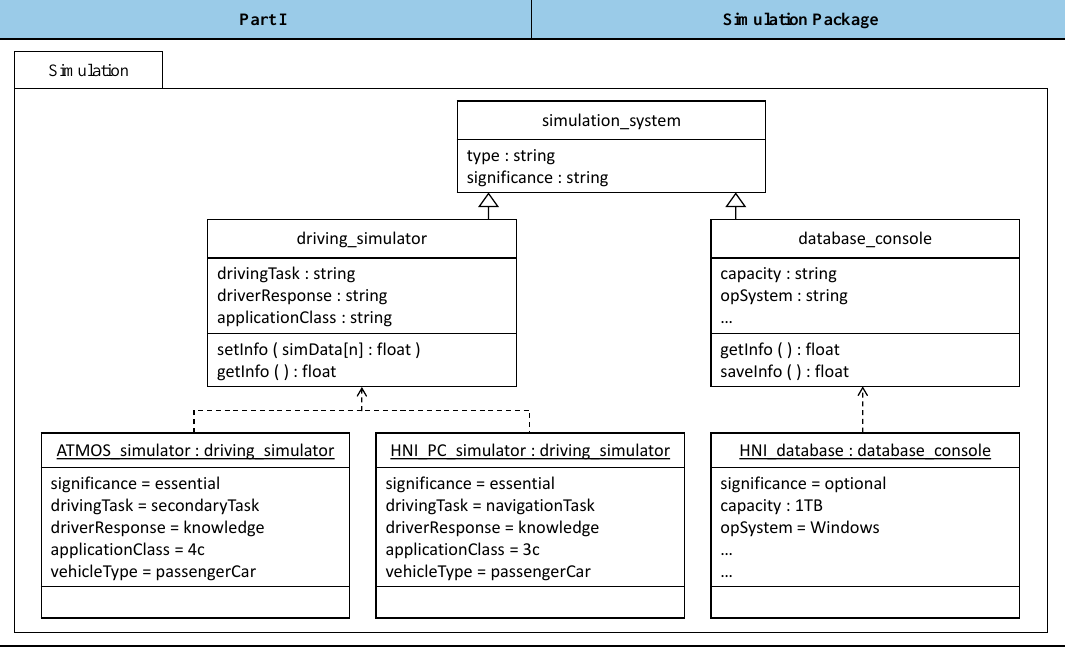
Figure 12. UML class diagram of the selected communication system components—package 2.